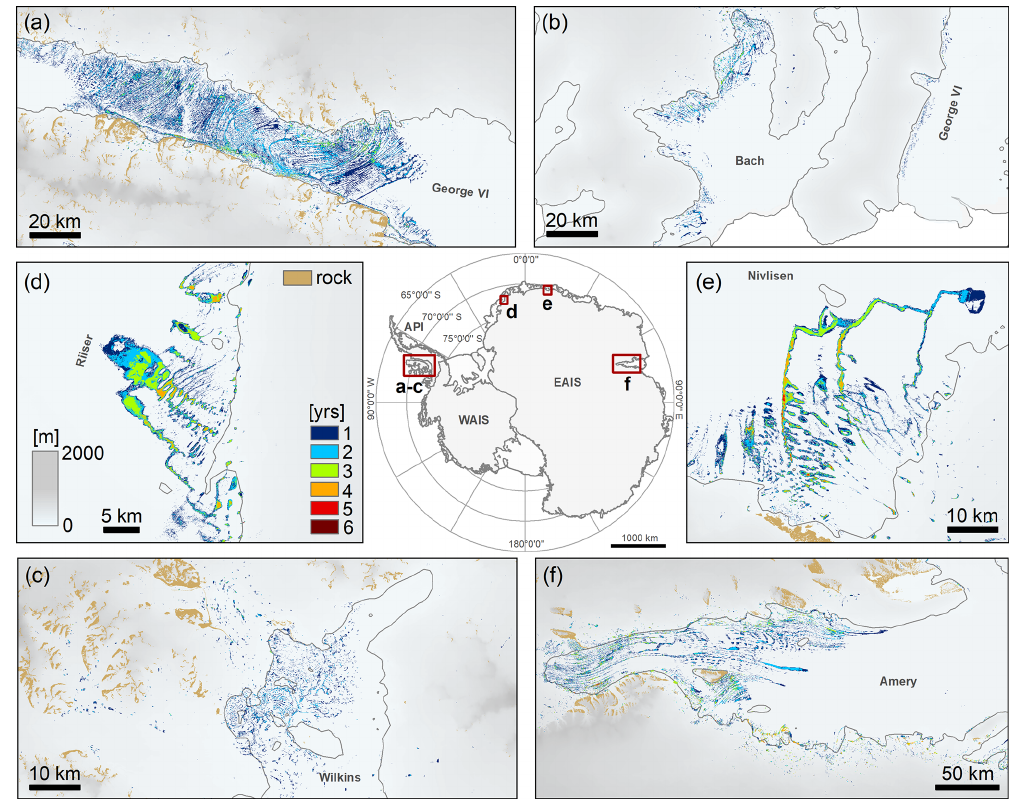
Figure 5. Inter-annual January recurrence of supraglacial lakes over George VI (a) , Bach (b) , Wilkins (c) , Riiser-Larsen (d) , Nivlisen (e) and Amery ice shelves (f) . The overview map in the middle shows the approximate location of the AOIs. The outline of the Antarctic ice sheets is taken from IMBIE (2016), the coastline and grounding line (grey) data are from Mouginot et al. (2017) and Rignot et al. (2013), and Sentinel-2 bedrock data are from Dirscherl et al. (2020). The background elevation is the gap-filled 200m Reference Elevation Model of Antarctica (Howat et al., 2019). In some regions, the movement of lakes with ice flow might have biased the calculation of annual lake recurrence times. Bigger map plots for each ice shelf can be found in Fig. S2. API: Antarctic Peninsula. WAIS: West Antarctic Ice Sheet. EAIS: East Antarctic Ice